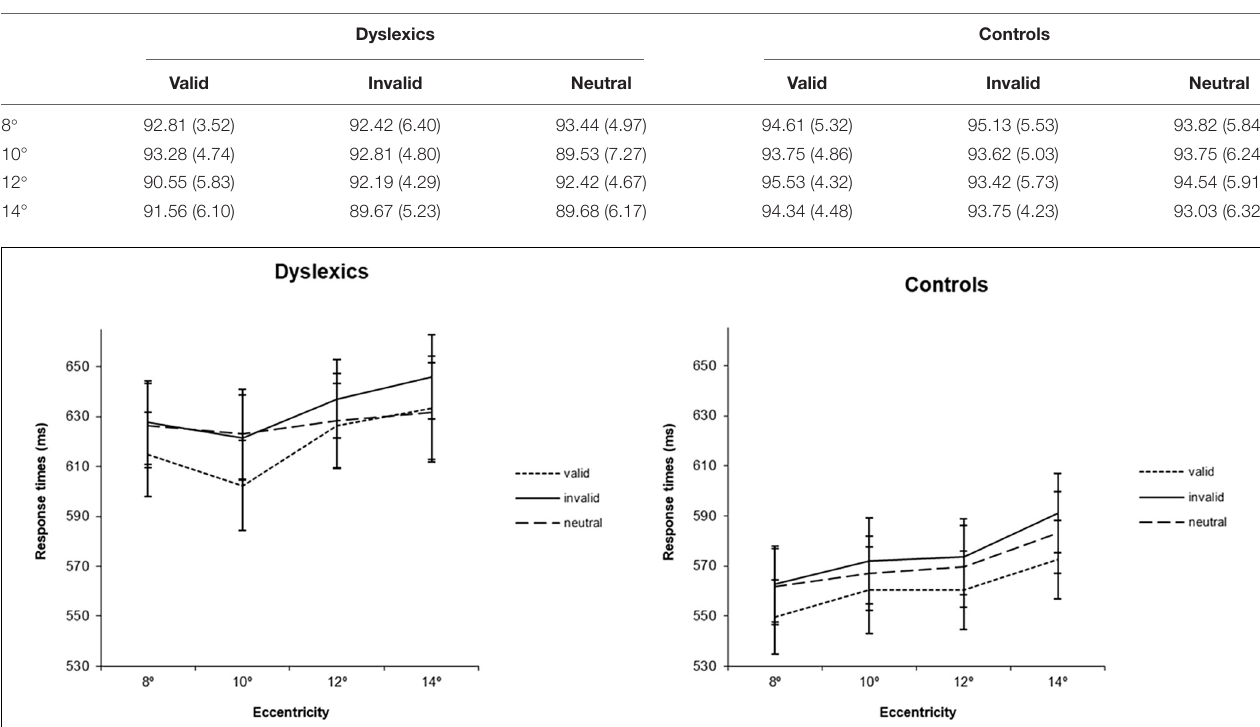
Frontiers in Psychology |